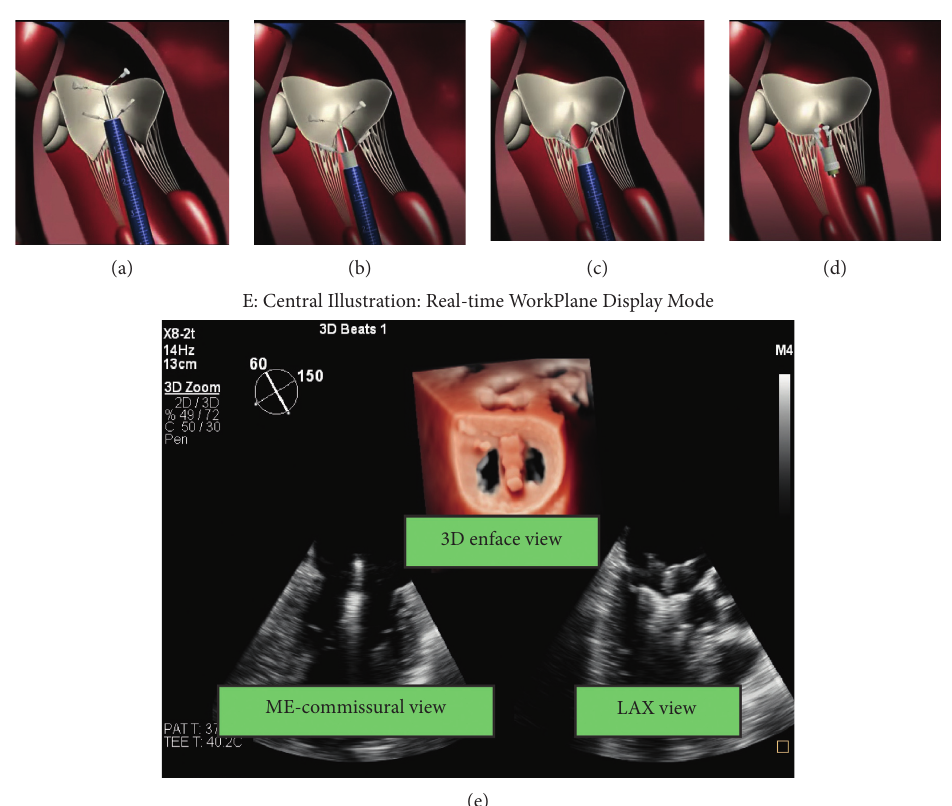
Figure 1: The main steps of ValveClamp implantation. (a) A clamp is delivered to the left atrium. (b) The clamp is adjusted to the appropriate position, and the rear clamp is placed just under the leaflets, while the front clamp remains in the left atrium. (c) The front clamp is pulled back to capture the leaflets, and then the closed ring is moved forward to cover the ventricular end of the clamp arms, making them close to each other. (d) The clamp is released. Reproduced with permission from Pan et al. [10]. (e) Central illustration. The real-time workplane display mode simultaneously depicted X-plane views and 3D enface MV views, which is essential for navigating the main steps of ValveClamp implantation. ME, midesophageal; LAX, long-axis